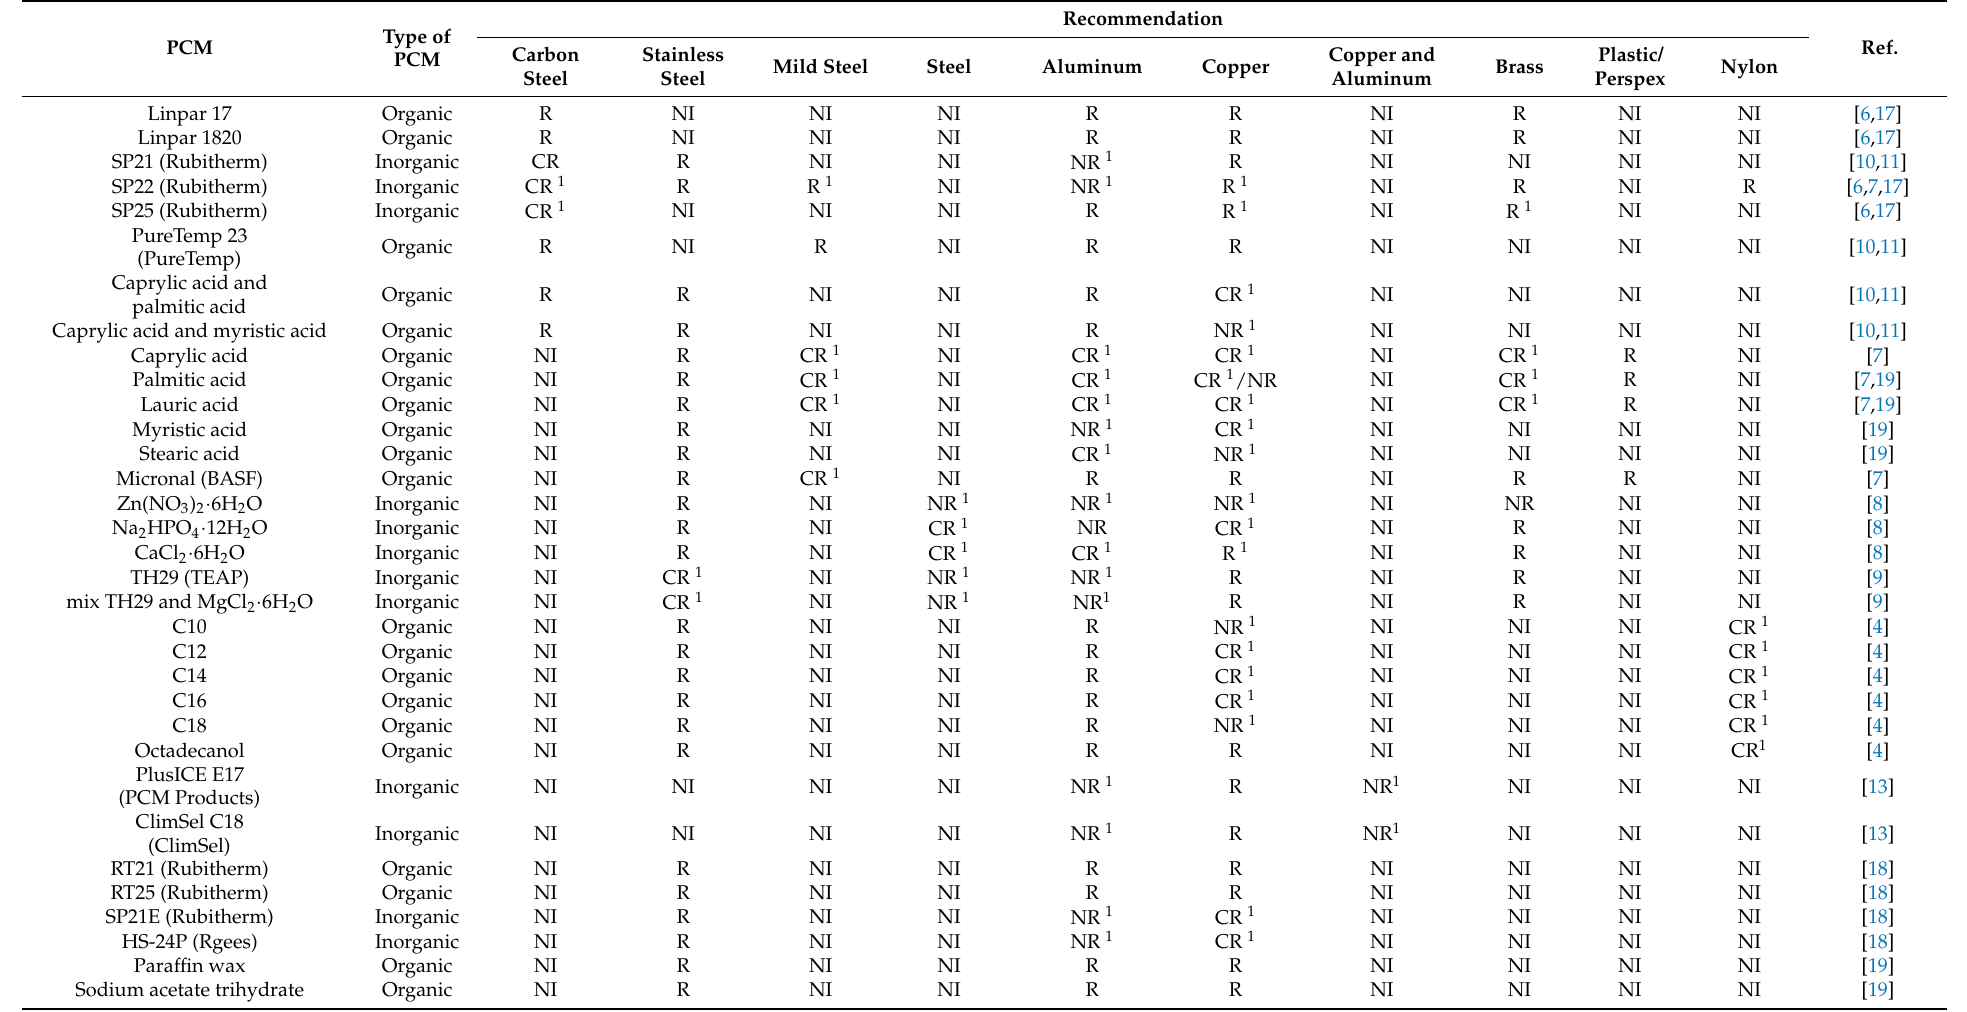
Table 1. List of recommendations regarding compatibility between PCM and potential LHTES materials or encapsulation